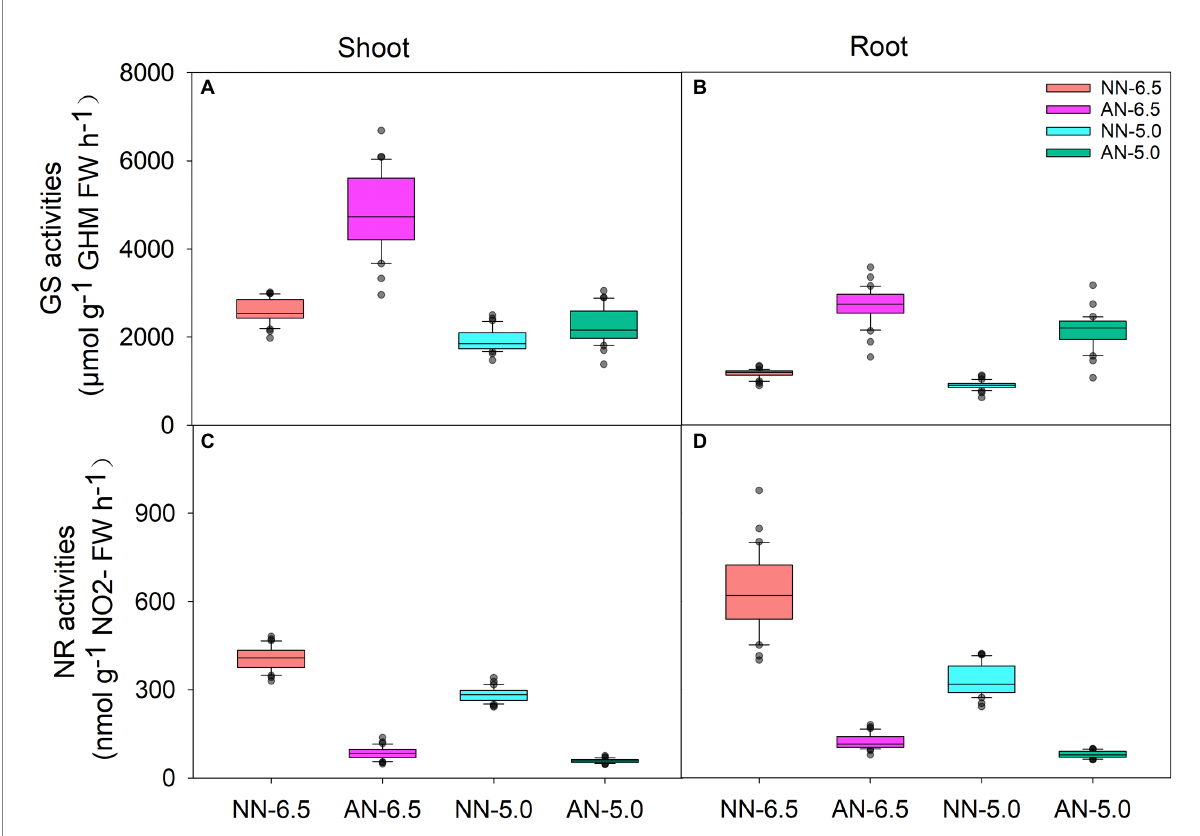
FIGURE 4 The enzymatic activities of GS and NR in shoots and roots of 31 wheat cultivars under different N-sources and pH levels. Data are means ± SE (n = 31). NN-6.5 refers to the nitrate nitrogen at a pH of 6.5; NN-4.5 refers to the nitrate nitrogen at a pH of 6.5; AN-6.5 refers to the ammonium nitrogen at a pH of 6.5; AN-5.0 refers to the ammonium nitrogen at a pH of 5.0.